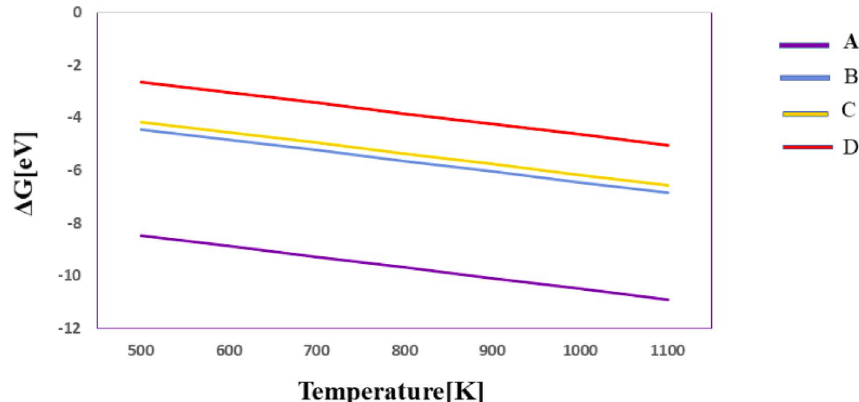
Fig. 7 Gibbs free energies ΔG (T, p) of the most stable molecu- lar ( m O 2 ) and dissociative ( d O 2 ) structures at {110} and {100} surfaces of defective 25% Ba-doped LaMnO 3 (LBM25). Color code: A = ΔG (eV) d O 2 at LBM25 {110}; B = m O 2 at LBM25 {110}; C = d O 2 at LBM25 {100}; D = m O 2 at LBM25